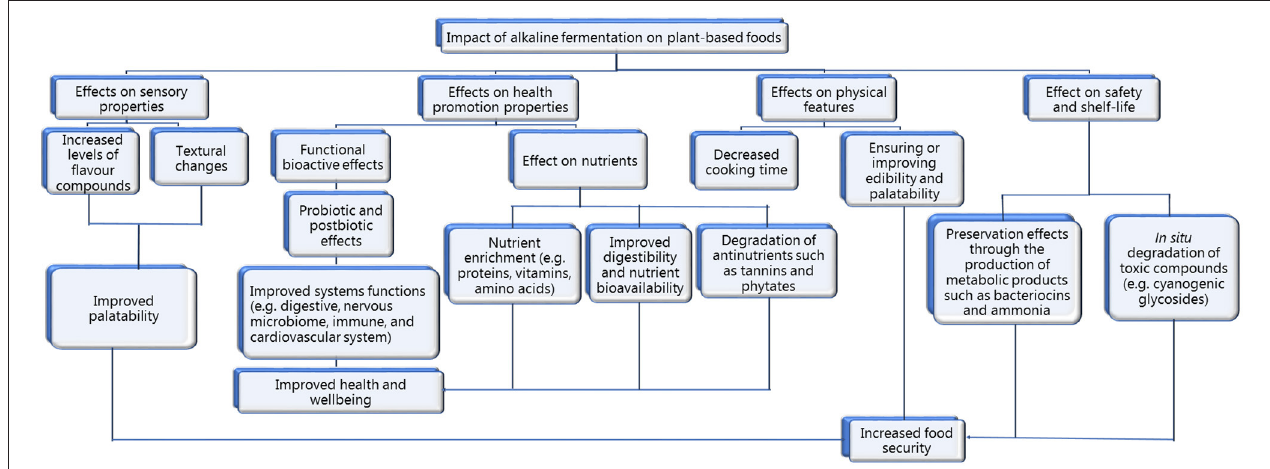
FIGURE 4 | Impact of alkaline fermentation on plant-based